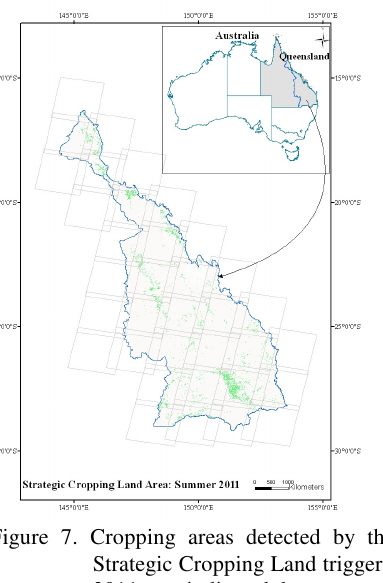
Figure 7. Cropping areas detected by this study within the Strategic Cropping Land trigger map during summer 2011, as indicated by green patches in the map. Overlaid is the footprints of 35 Landsat scenes that cover the study area.